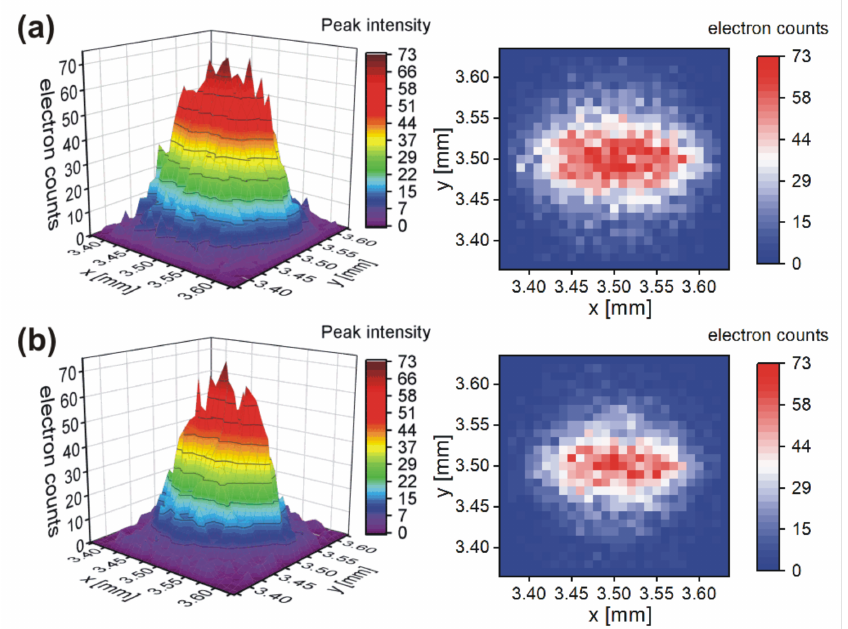
Figure 7. Three-dimensional plots and heat maps for the best focus voltages on the membrane: